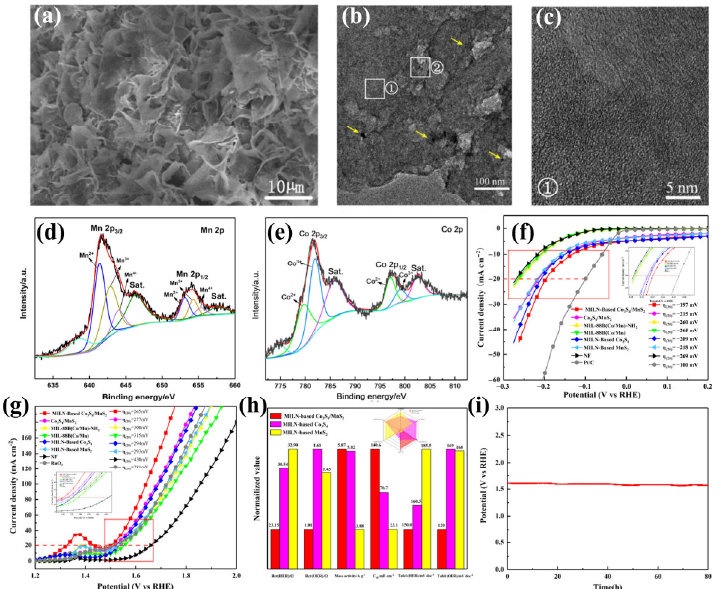
Figure 10. ( a ) FESEM image, ( b ) TEM image, and ( c ) HRTEM of MILN-based Co 3 S 4 /MnS 2 . ( d , e ) XPS spectra of Mn 2p, Co 2p. ( f ) HER and ( g ) OER polarization curves in 1.0 M KOH, with a scan rate of 1 mV s − 1 . ( h ) Comparing the activity between MILN-based Co 3 S 4 /MnS 2 , MILN-based Co 3 S 4 and MILN-based MnS 2 in 1.0 M KOH. ( i ) Chronopotentiometry test of MILN-based Co 3 S 4 /MnS 2 at 20 mA cm − 2 current density under overall water splitting. Reproduced with permission from Ref. [40]. Copyright 2021, Elsevier